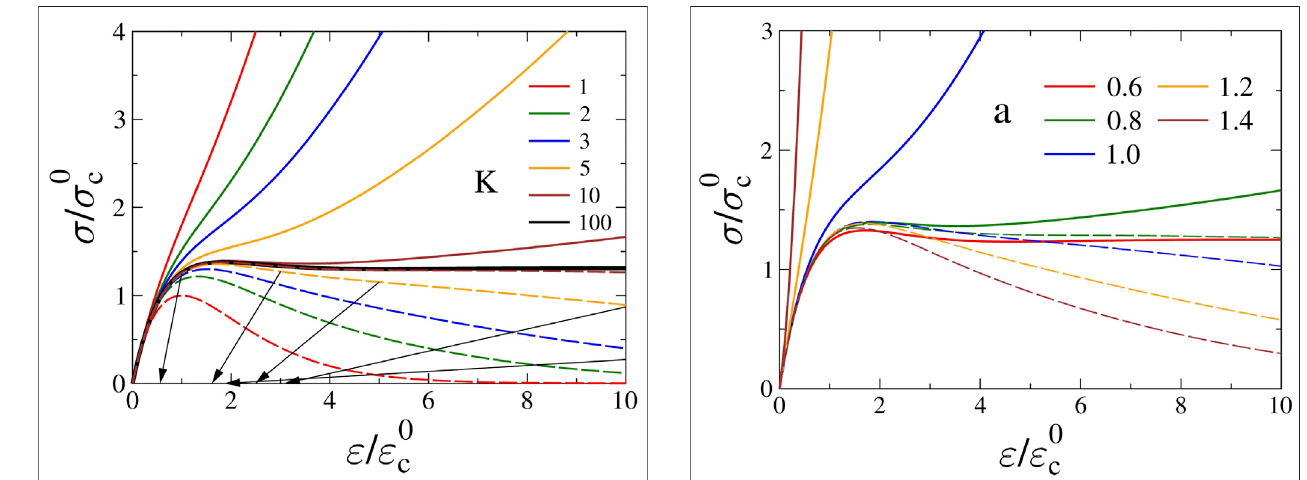
FIGURE 3 | The effect of the value of the stiffness parameter a on the macroscopic behavior of a bundle where all fi bers are allowed to perform K (cid:1) 10 stick-slip cycles. Constitutive curves of hardening (continuous lines) and softening (dashed lines) bundles are also included. The slip thresholdsareexponentiallydistributed. Fiberskeep their fi nalstiffnesssothat all bundles are hardening even if the asymptotic regimes are not visible for the lowest a